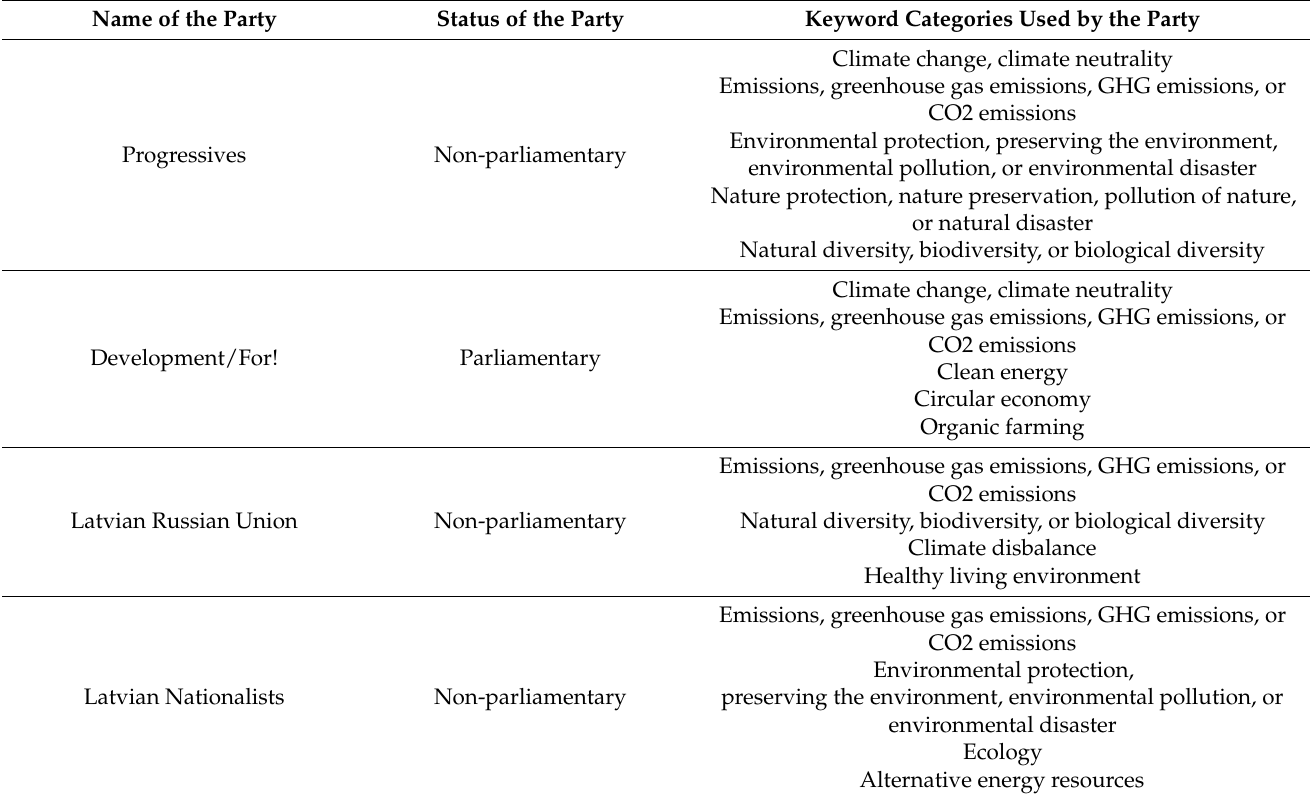
Table 4. Keyword categories identified in each party’s programme. Keyword Categories Used by the